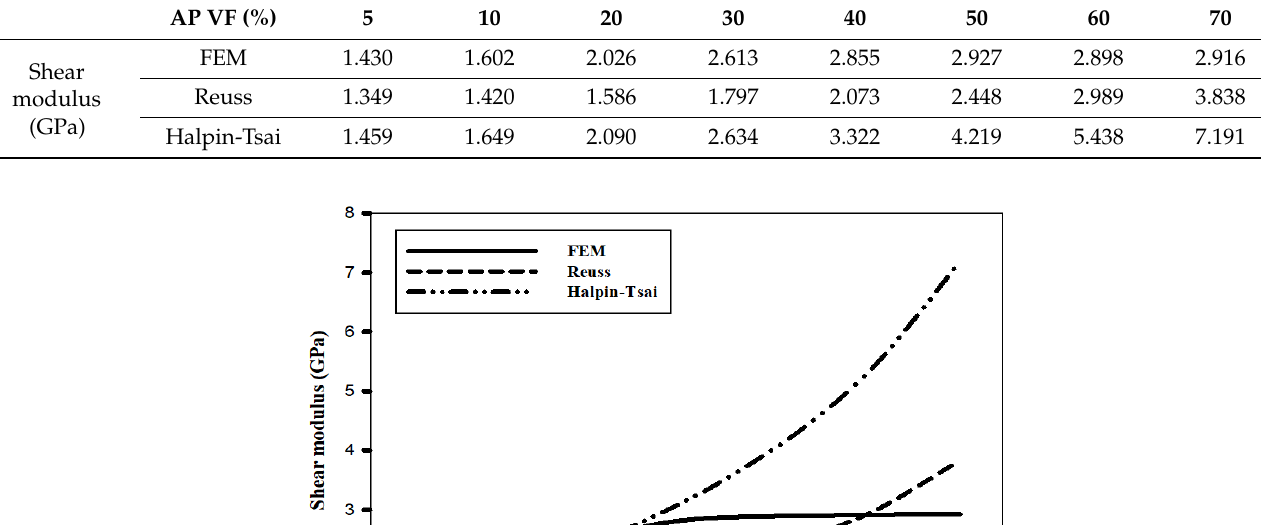
Table 5. FEM and numerical analysis predictions of shear modulus.